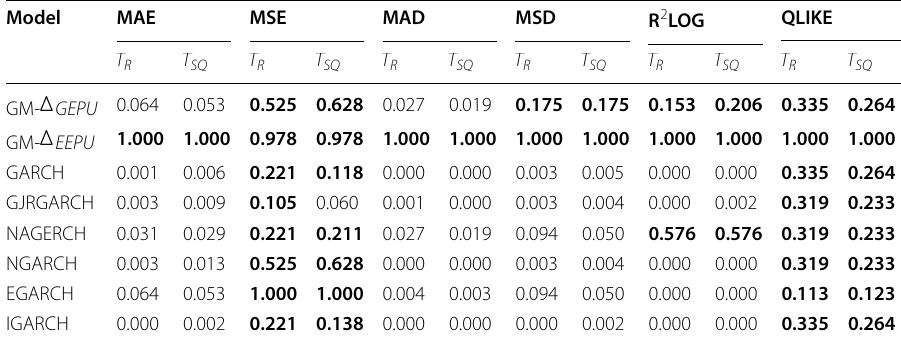
Table 4 MCS test results of the model (400-day out-of-sample prediction window)